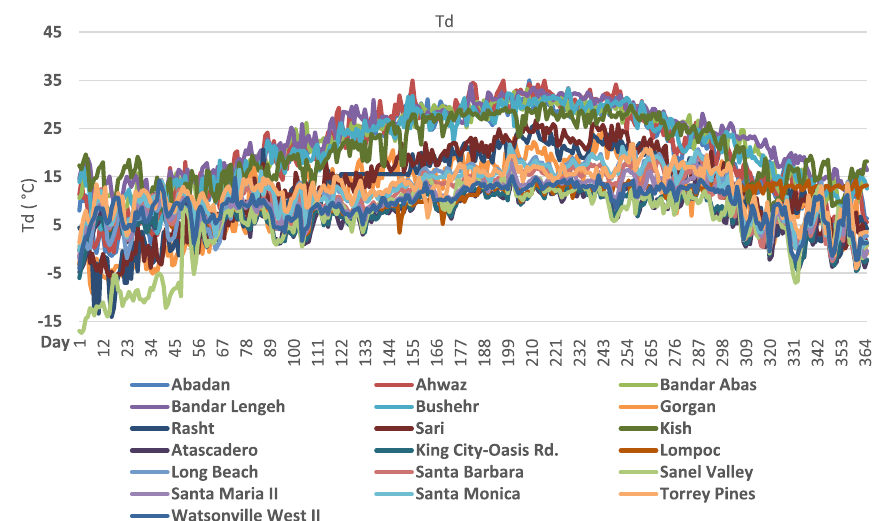
Fig. 7 Temperature of dew point based on 365 days from various stations